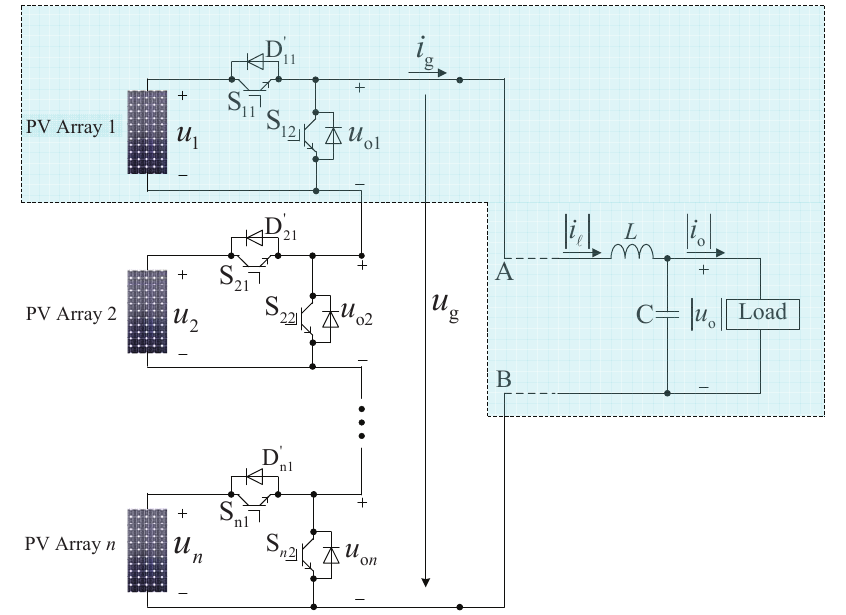
Figure 2. The structure of the topology leaving out the details of the second